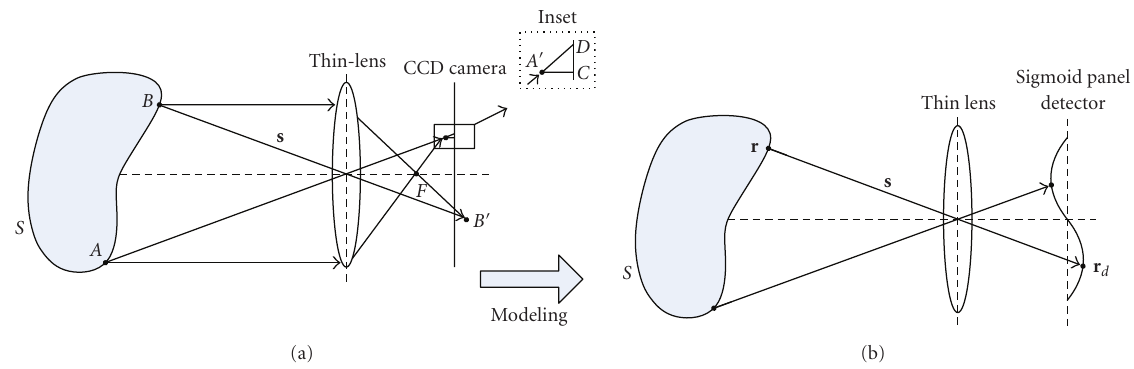
Figure 1: Schematic diagram for the simplification of optical imaging system.